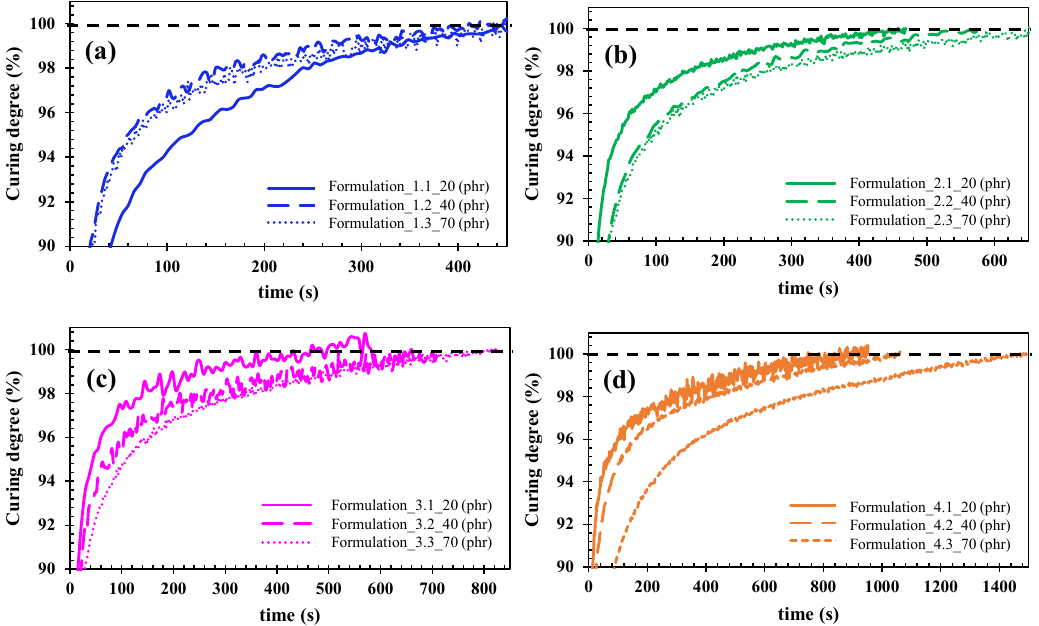
Figure 2. Curing degree evolution for all resin/flame-retardant fillers formulations as a function of time. ( a ) Formulation 1 (fillers Apyral20X at 20 (1.1), 40 (1.2) and 70 (1.3) phr); ( b ) Formulation 2 (fillers Apyral 30X at 20 (2.1), 40 (2.2) and 70 (2.3) phr); ( c ) Formulation 3 (fillers Apyral 22 at 20 (3.1), 40 (3.2) and 70 (3.3) phr); ( d ) Formulation 4 (fillers Apyral 33 at 20 (4.1), 40 (4.2) and 70 (4.3) phr). Dotted lines are drawn for visual interpretation of total curing degree.